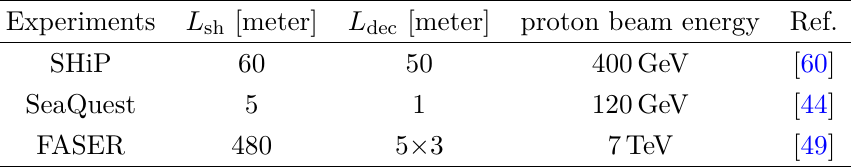
Table 1 . Configurations of future BD